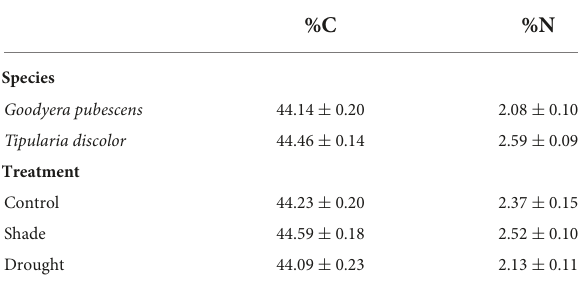
TABLE 2 Carbon (%C) and nitrogen (%N) concentrations (each mean ± se) of G. pubescens and T. discolor across all treatments (top two rows) and concentrations across treatments (bottom three rows).